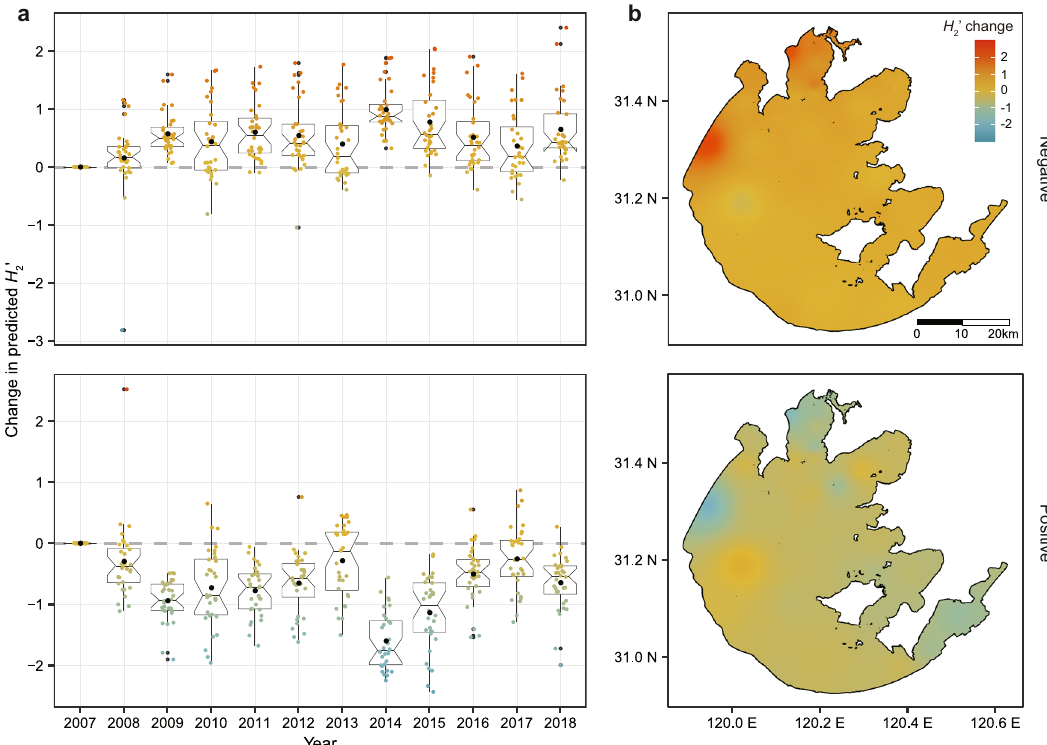
Fig. 7 Decadal change in predicted specialization of DOM-bacteria networks in Taihu Lake. a Changes in H 2 ′ of negative (upper panel) and positive (lower panel) bipartite networks from 2007 to 2018. b The spatial distribution of changes in H 2 ′ of negative (upper panel) and positive (lower panel) networks in 2018 across the Taihu Lake. Estimated changes in H 2 ′ were calculated ( n = 32 sampling sites across the whole of Taihu Lake; Fig. S19a) by comparing with the baseline of 2007, and represent the combined effects of climate change and eutrophication. The colored dots in a indicate H 2 ′ changes for individual sites which are consistent with the fi gure legend of ( b ), and black dots are the mean values for each year. The box in a represents the interquartile (50% of data), the horizontal line in the box represents the median, the “ notch ” represents the 95% con fi dence interval of the median and the “ whiskers ” represent the maximum and minimum